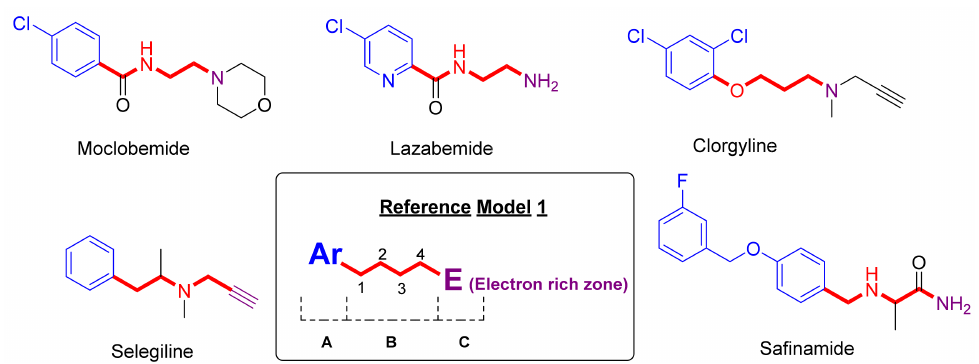
Figure 1. MAO-inhibitors (Moclobemide, Selegiline, Clorgyline, Lazabemide, and Safinamide) and their common structure